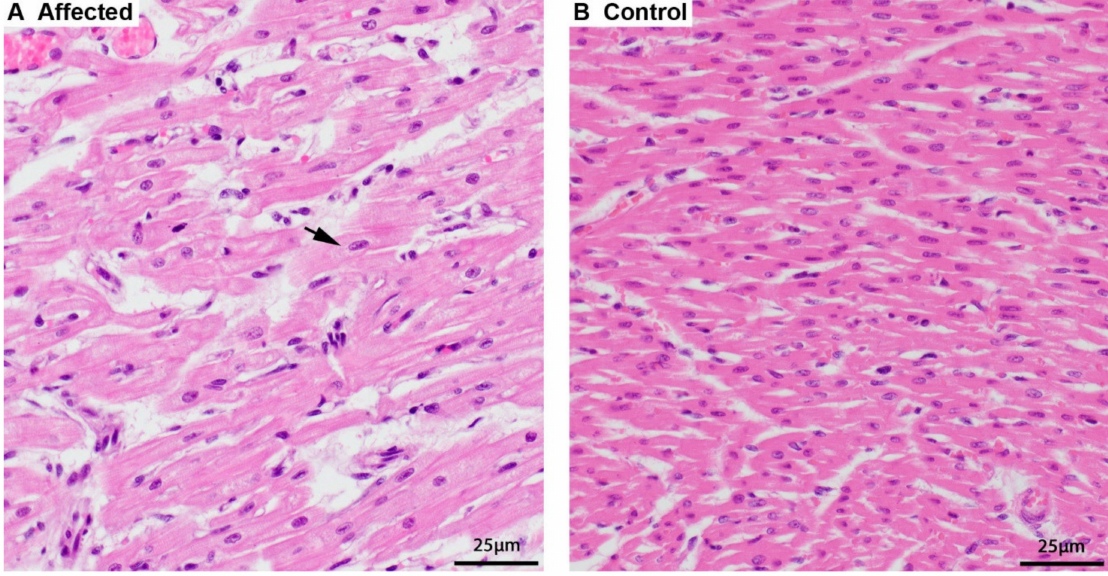
Figure 1. Histopathology of the heart. ( A ) Cardiomyocytes of an a ff ected puppy are swollen and pale, and the sarcoplasm around the nucleus is dispersed (arrow) by finely granular material, hematoxylin and eosin (HE) stain. ( B ) Normal, smaller, and more intense staining of cardiomyocytes of a 5-week-old control puppy, HE